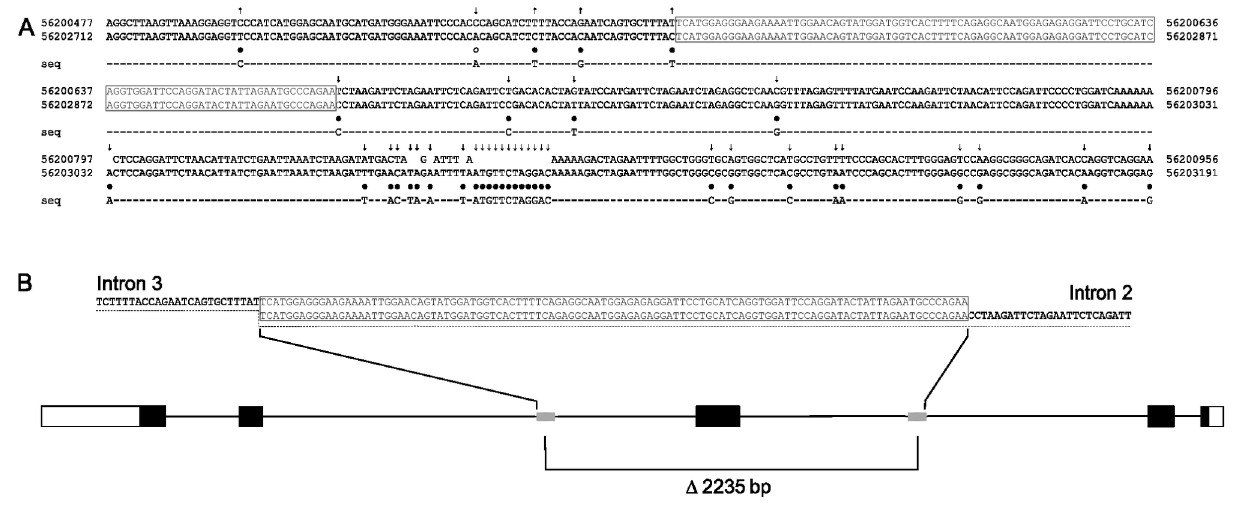
Figure 2. Location of the breakpoint sequences of the deletion in the KLK9 gene. (A) An alignment of two repeated sequences of the KLK9 gene is shown together with their chromosome positions (Build 36.3). Dots highlight positions where the two sequences are different (unfilled dot shows a polymorphic nucleotide position). The line marked ‘seq’ is the result of the DNA sequencing of deletion-carrying individuals. Arrows indicate which of the homologous sequences agrees with the sequence from the deletion-carrying individuals: an arrow pointing up shows that the upper sequence agrees and an arrow pointing down shows that the lower sequence agrees. The differences between the two homologous sequences, indicated by boxes, limit the exact breakpoint position. (B) Breakpoints of the deletion are located between nucleotides 56 200 564-56 200 671 in intron 3 and nucleotides 56 202 799-56 202 906 in intron 2 of the KLK9 gene, which results in a 2235-bp deletion eliminating exon 3.